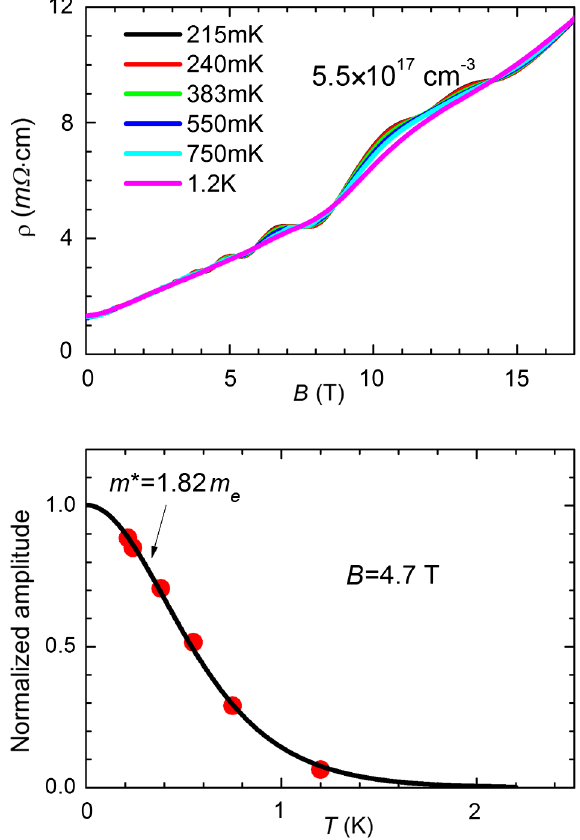
FIG. 4. Top: The Shubnikov–de Haas effect is visible in the magnetoresistance of the lowest doped SrTiO 3 sample. Bottom: The effective mass obtained from the resistivity data is close to the one obtained by the analysis of the Nernst